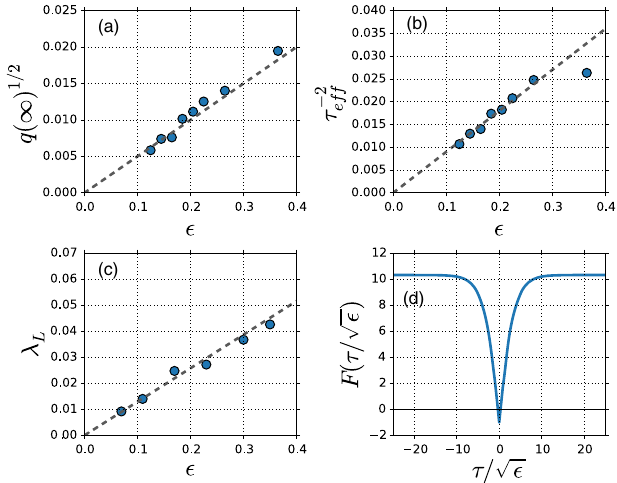
FIG. 8. Critical behavior of a single inhibitory population with linear transfer function. Normalized variance (a) network relax- ation time (b), and largest Lyapunov exponent (c) as a function of g 2 − 1 . Circles show the the distance from the critical point ϵ ¼ 1 2 average over 20 simulations (Gaussian connectivity, N ¼ 6000 , h 0 ¼ 1 ), and dashed lines show theoretical predictions (see Appendix E). (d) Rescaled one-dimensional quantum potential ffiffiffiffi p ϵ Þ F ð τ = , Eq. (63), for the Hamiltonian in Eq. (29).